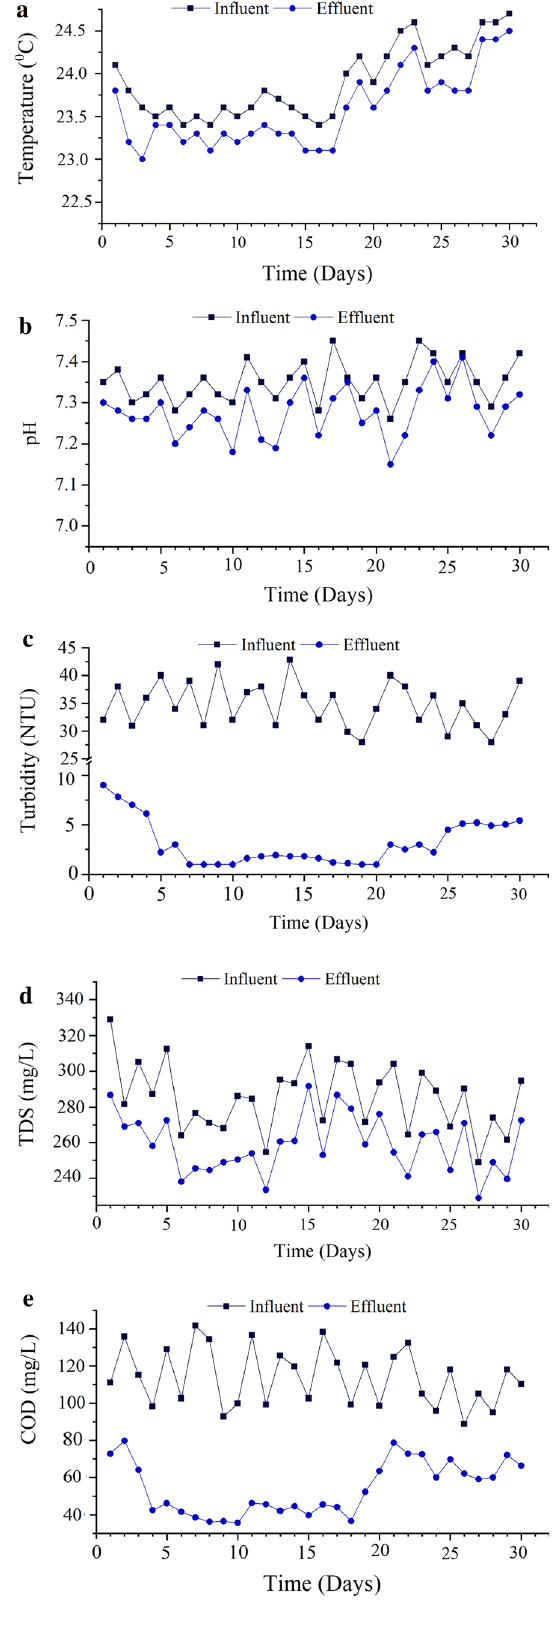
Fig. 2 Temporal variations in the physicochemical properties of a water temperature; b pH; c turbidity; d TDS; and e COD of influent and effluent greywater samples